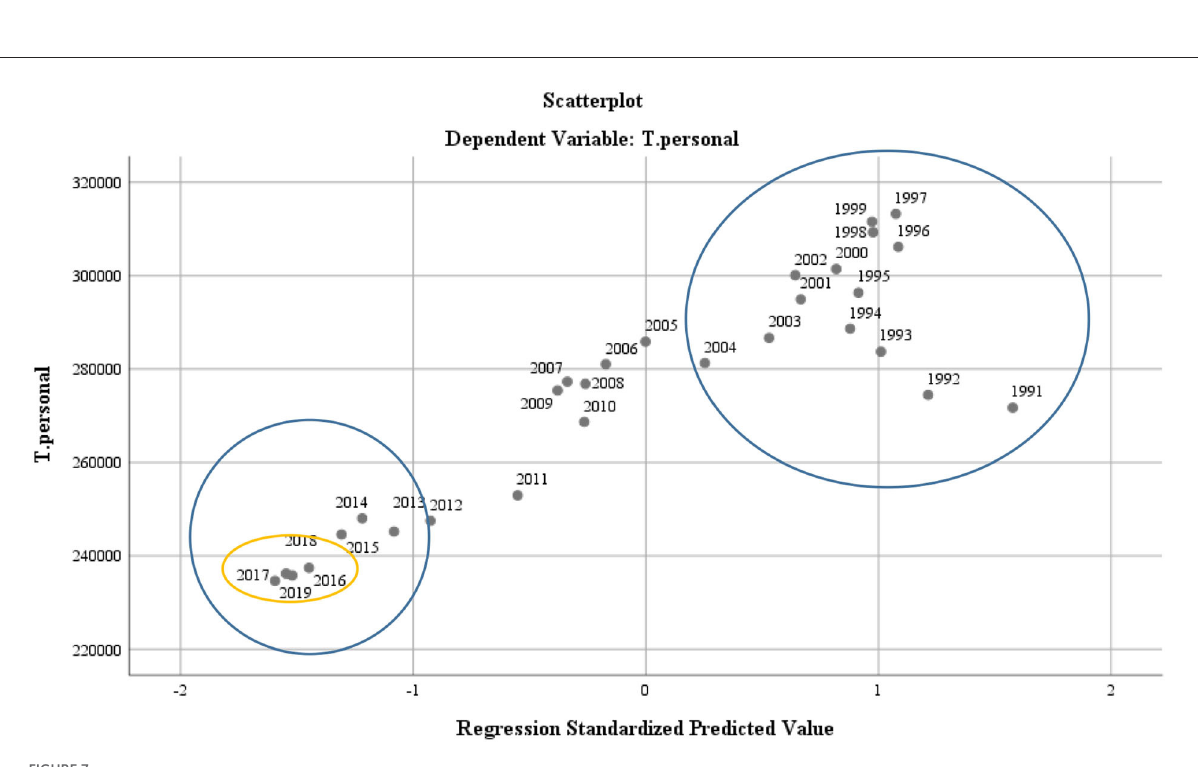
FIGURE7 Scatter diagram—for representing the dynamics of the staff in the Romanian educational